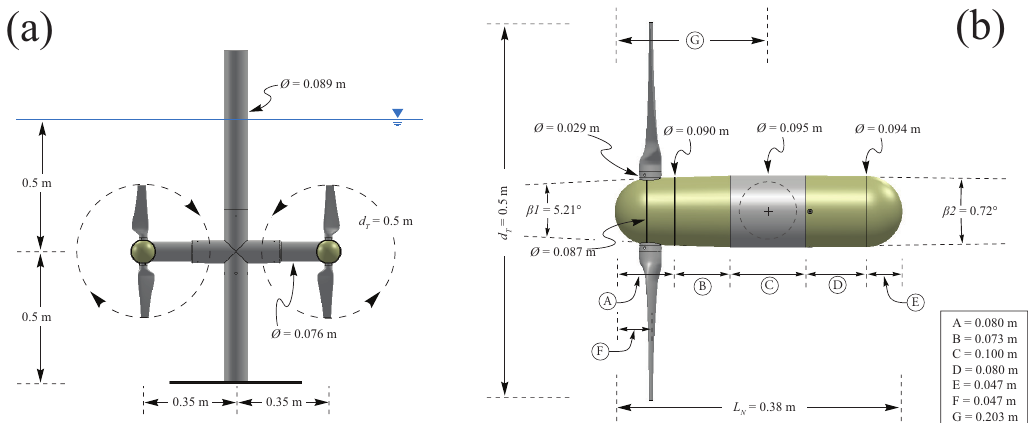
Figure 1. ( a ) Photo of RM1 installed in the SAFL Main Channel Facility. ( b ) CAD image showing internal instrumentation setup for data acquisition of turbine performance.